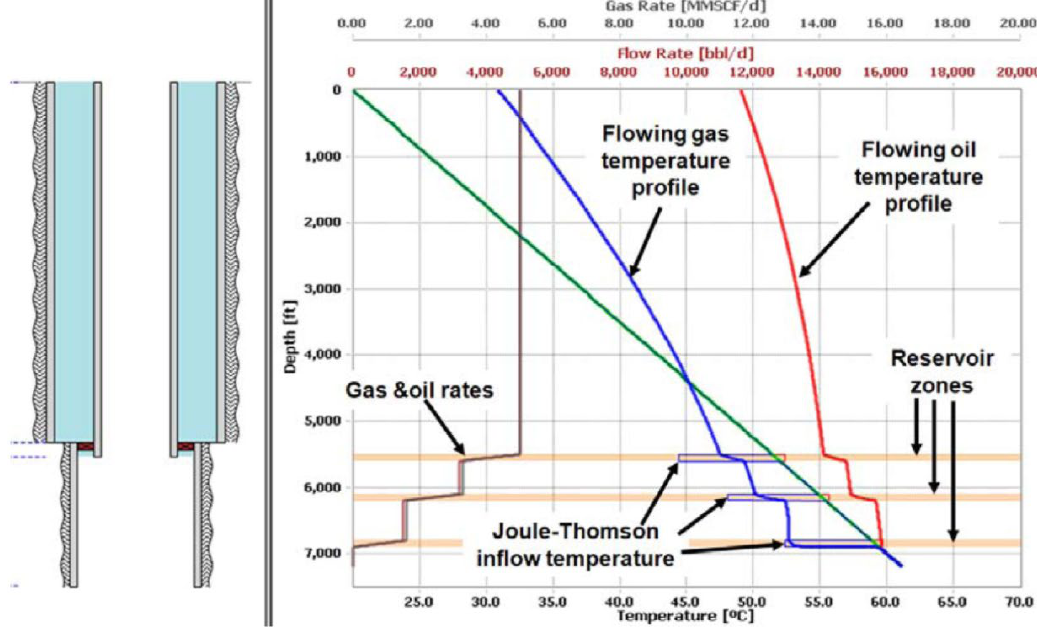
Figure 6. Joule–Thomson Effect in the reservoir and temperature profile [11].